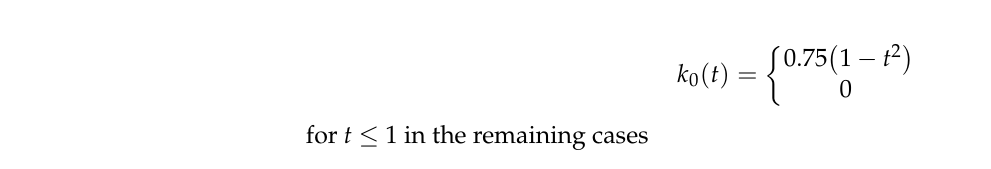
Table 1. Thematic groups of social problems. Source: Own